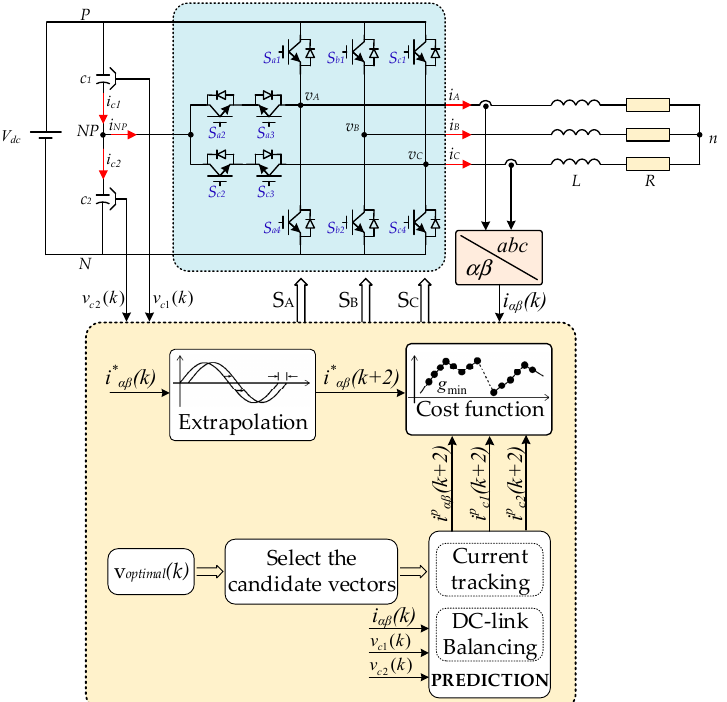
Figure 4. Block diagram of improved MPC algorithm for the asymmetric T − type NPC inverter.